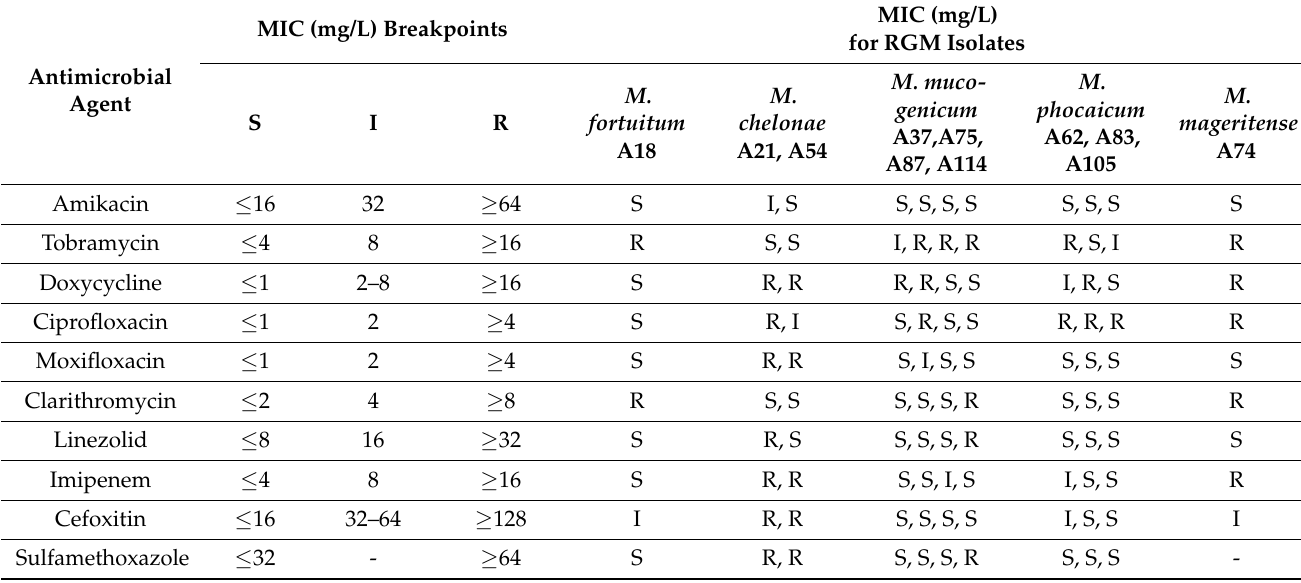
Table 3. Minimum inhibitory concentration for nontuberculous mycobacteria isolated from drinking water in Cali, Colombia.